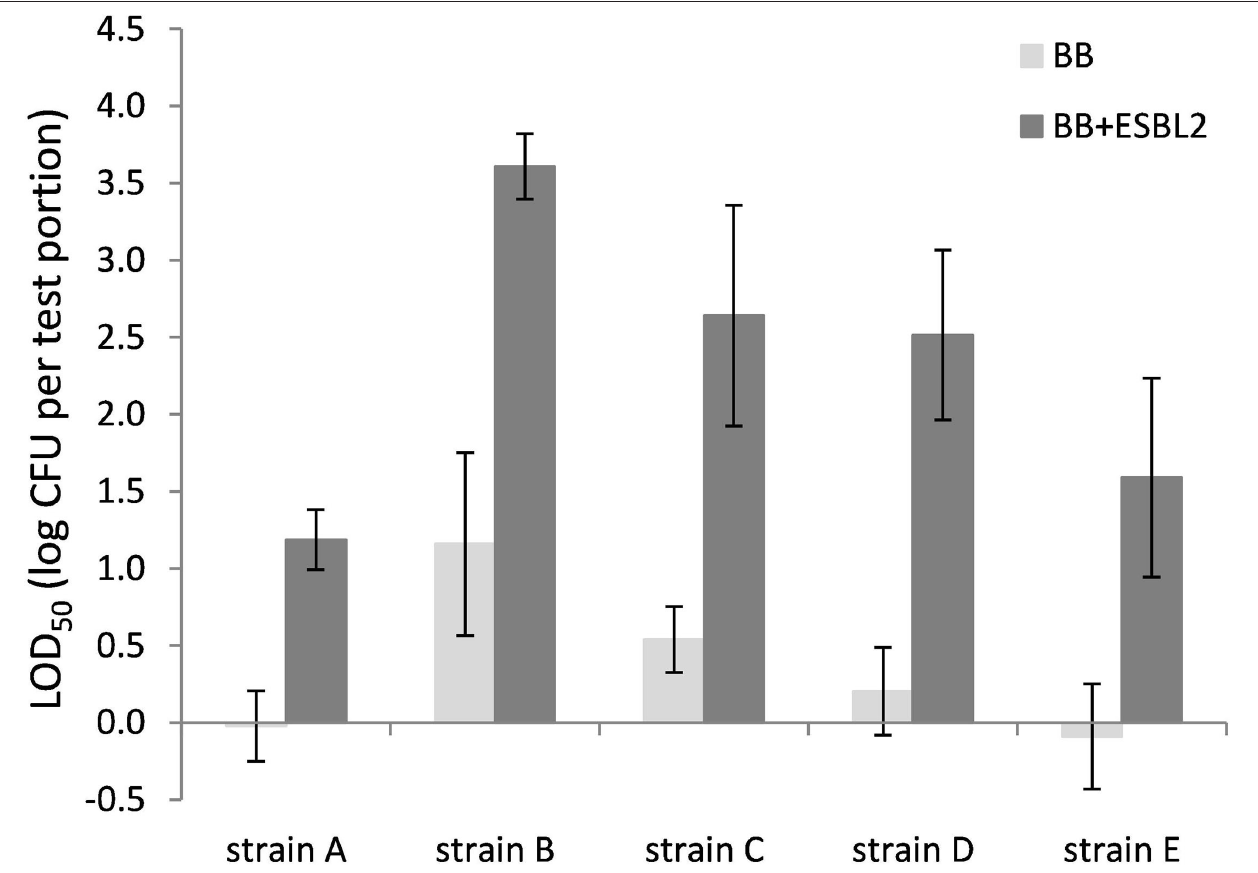
FIGURE 3 | LOD 50 of C. jejuni strains A, B, and D and C. coli strains C and E. Enrichment in Bolton Broth ( n = 2–7) and with co-inoculation of E. coli ESBL 2 ( n = 2–5) in raw milk. Error bars indicate the standard deviation.